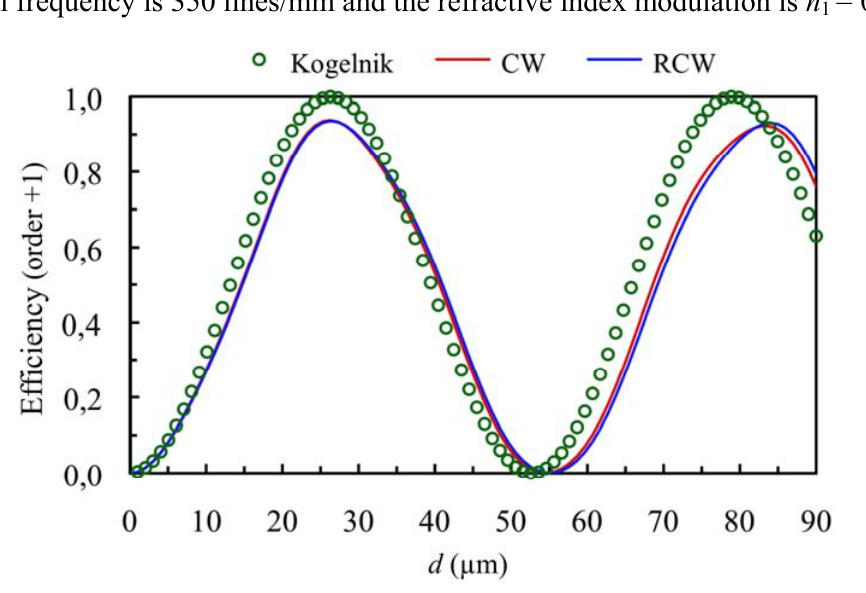
Figure 3. Diffraction efficiency of order +1 (first order diffracted), at first Bragg’s angle. The spatial frequency is 350 lines/mm and the refractive index modulation is n